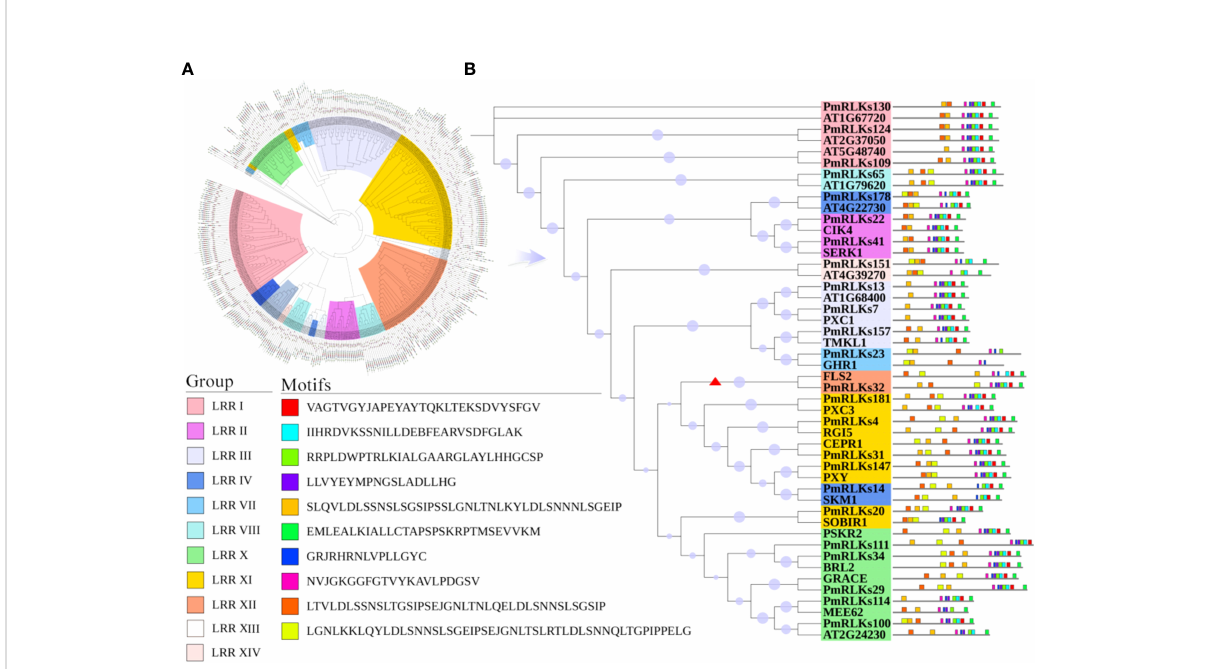
FIGURE 1 Motifs and phylogenetic tree for PmRLK proteins. (A) Phylogenetic tree based on the full-length amino acid sequences using the maximum likelihood method. The different subgroups are indicated by different colors. (B) Motifs and phylogenetic tree for P. massoniana and A. thaliana homologs. The red arrowhead shows the genes that were selected for further